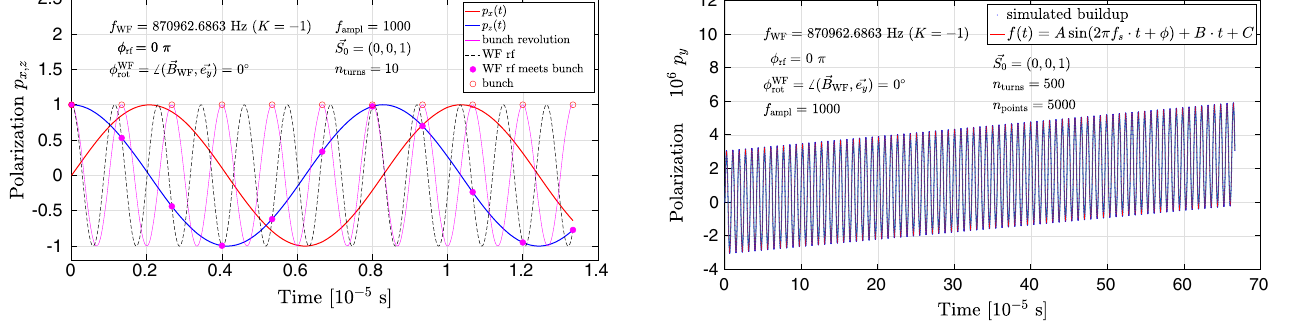
FIG. 9. Buildup of a vertical polarization component for the conditions as indicated. The amplitude of the oscillating ð t Þ corresponds to the EDM tilt angle ξ p , given in Table I. y EDM The red line is a fit to the data using Eq. (72) that yields an initial ¼ 10 3 . Also , and f ð t Þ = d t j ¼ B ¼ ð 4305 . 059 (cid:4) 5 . 268 Þ × 10 − 6 s − 1 (for slope of d p y ampl y t ¼ 0 ¼ 10 3 f ampl